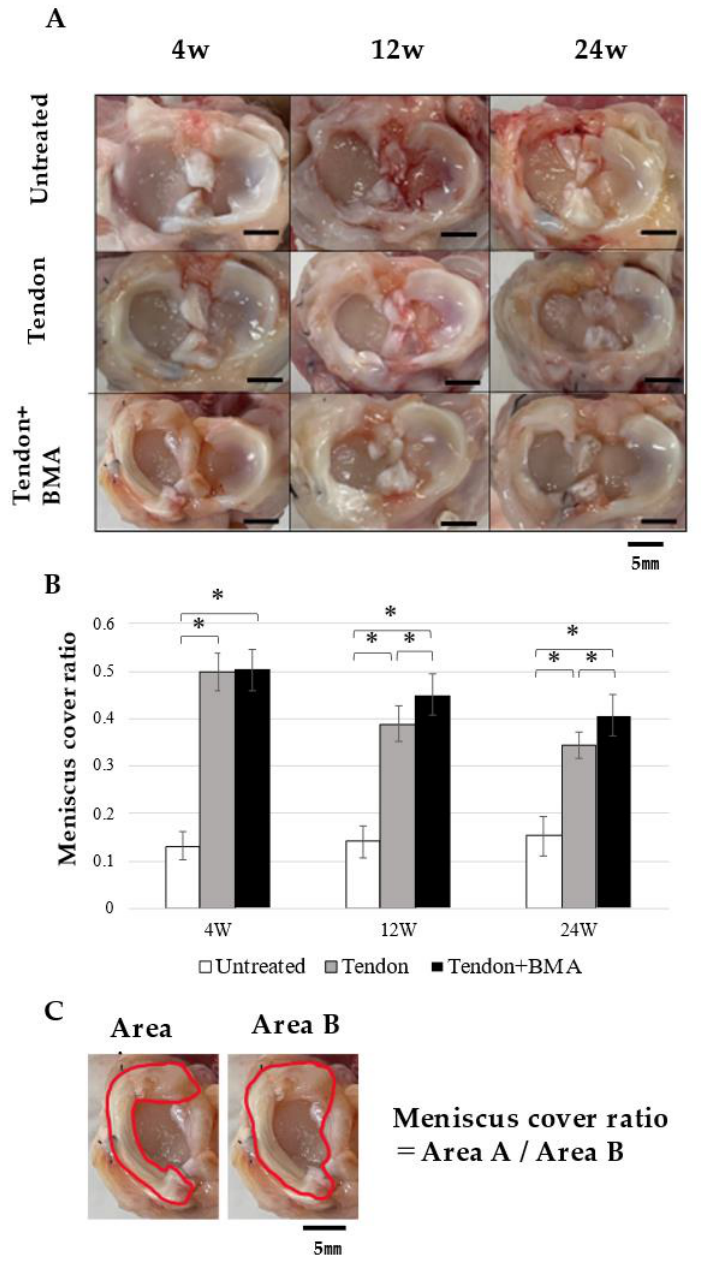
Figure 1. Macroscopic analyses for regenerated meniscus. ( A ) Macroscopic observation. Scale bar = 5 mm. ( B ) Meniscus cover ratio. Bars show the mean ± SD ( n = 6). *, p < 0.05; At 12 and 24 weeks, the meniscus cover ratios in the tendon + BMA group were larger than those in the tendon group and untreated group. ( C ) Explanation for meniscus cover ratio, defined as the ratio of medial meniscus area (red line of Area A) to medial plateau area (red line of Area B).